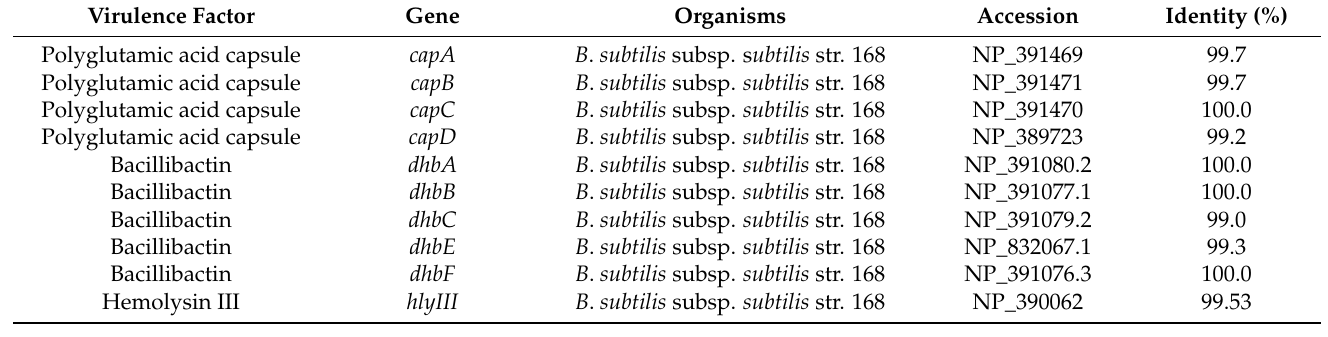
Table 3. Genome screening of B . subtilis IDCC1101 for detecting virulence factors using the VFDB database.